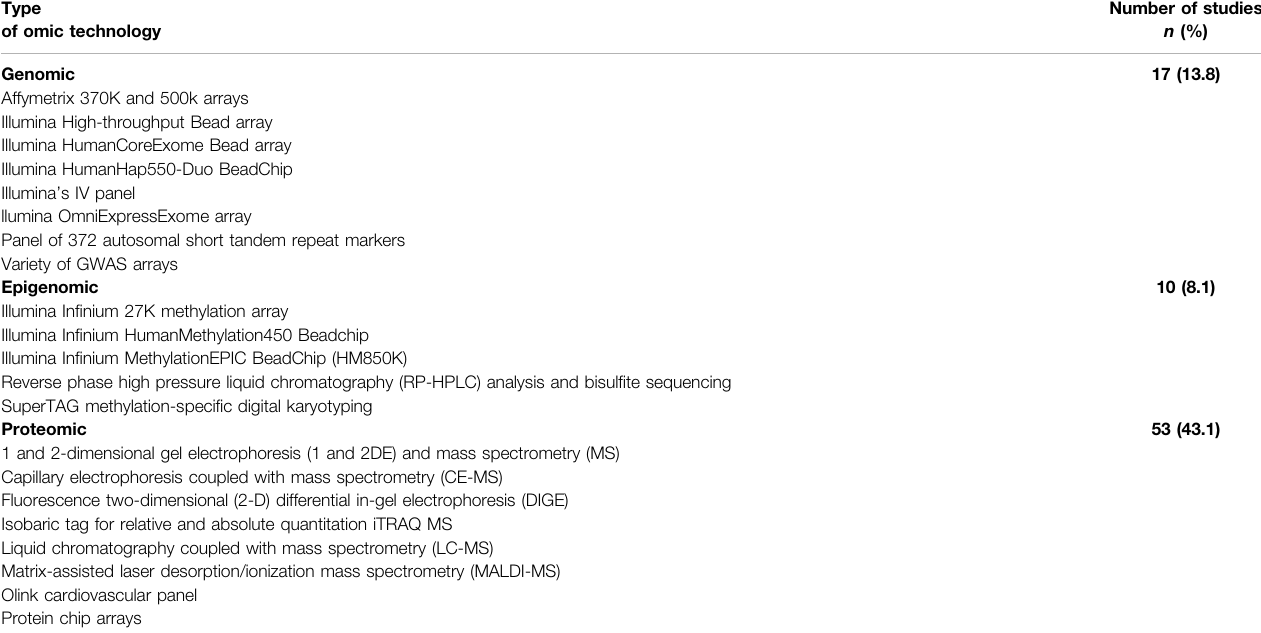
Number of studies n